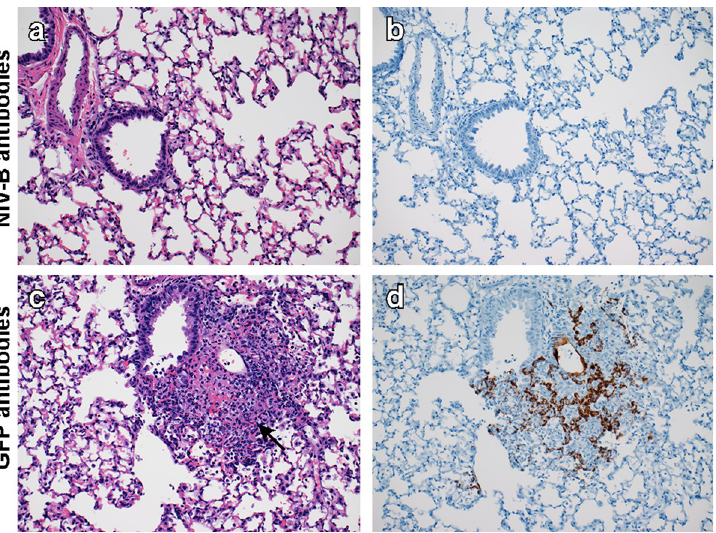
Fig 6. Treatment with IgG antibodies elicited by ChAdOx1 NiV B vaccination reduced pathology and viral RNA abundance in Syrian hamsters challenged with NiV Bangladesh. Hamsters were treated with NiV or GFP antibodies and challenged with NiV Bangladesh. Lung tissue was collected at D5. Tissue sections were stained with hematoxylin- eosin (left panels) or with target-specific probes for viral RNA, which is visible as a brown staining (right panels). (a-b) Lung tissue obtained at D5 of animals treated with NiV antibodies. (c-d) Lung tissue obtained at D5 of animals treated with GFP antibodies. Arrow in H&E = Inflammatory cells, fibrin, edema and hemorrhage centered on terminal bronchioles. 200x magnification. H&E and ISH slides were from sequential